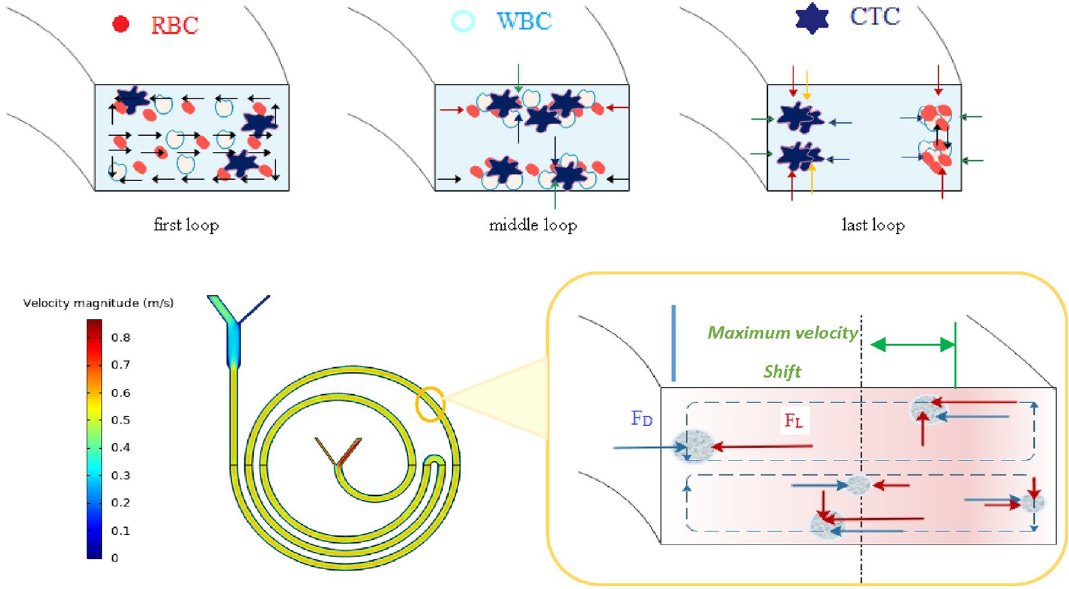
Figure 2. The effect of secondary flow on cell isolation in a curved channel, where larger particles accumulate near the inner wall and smaller particles near the outer wall. Firstly, the lift forces act on the particles and the particles accumulate in an equilibrium position in the middle of the walls. Finally, the smaller particles migrate toward the outer wall due to the presence of transverse secondary flows. The red arrows indicate the lift force, and the blue arrows indicate the drag force. The channel’s curvature causes the maximum velocity to be transferred to the outer half of the channel. Larger particles are subjected to a larger lift force so they cannot pass through the outer half, and large particles initially in the outer half are driven into the inner wall by both lift and drag forces. On the other hand, the vertical lift force on small particles is not enough to send the particles up and down the channel to follow the flow, thus remaining in the outer